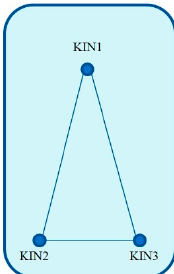
Figure 2. Relative positions of the kinematic GNSS antennas on the ship.